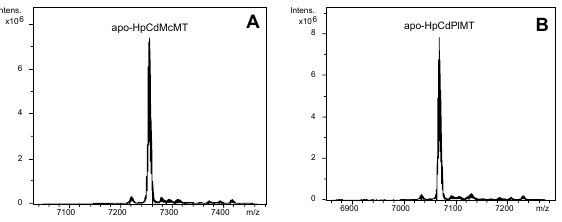
Figure 1. Sequence alignment of the recombinant proteins studied in this work: the constructs HpCdMcMT and HpCdPlMT are aligned with the HpCdMT wild-type form. The Cys residues are written in red, and the linker residues are shaded in grey. The initial Gly, which is a remainder from the thrombin cleavage site, is printed in italics. apo-HpCdMcMT